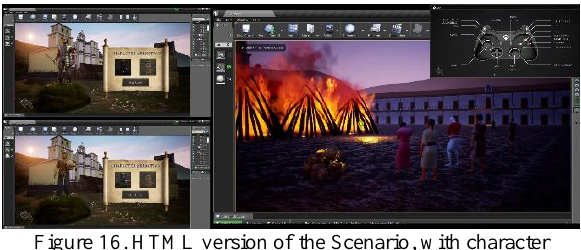
Figure 16. HTML version of the Scenario, with character selection option.